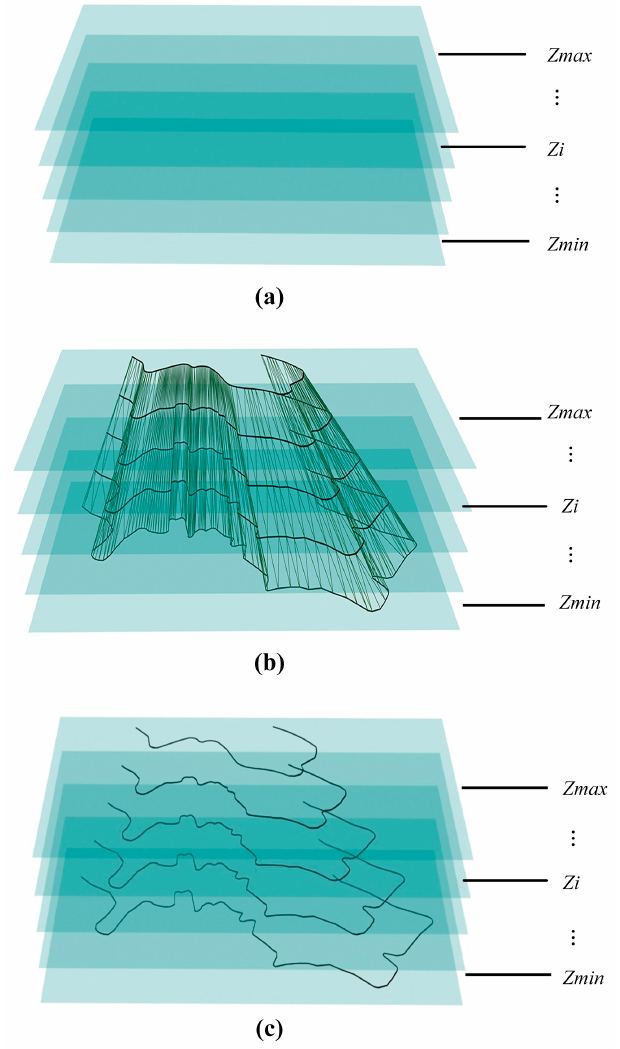
Figure 6. Intersection between the CCS-mesh and horizontal planes. ( a ) A set of horizontal planes. ( b ) The intersection between CCS-mesh and horizontal planes. ( c ) The simplified contours on horizontal planes.